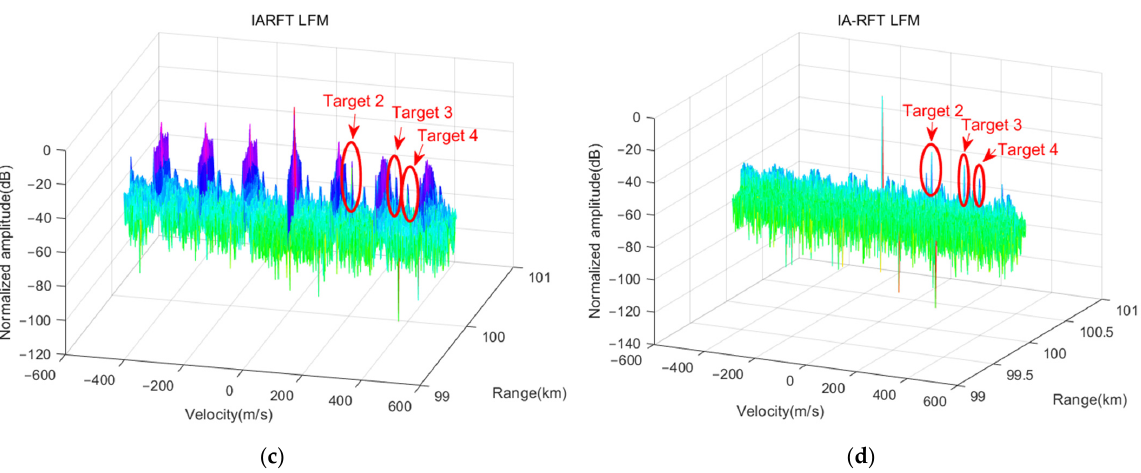
Figure 8. Stereogram output of four methods in Scenario 2. ( a ) Output of RFT; ( b ) Output of ARFT; ( c ) Output of IARFT; ( d ) Output of APC-IARFT.